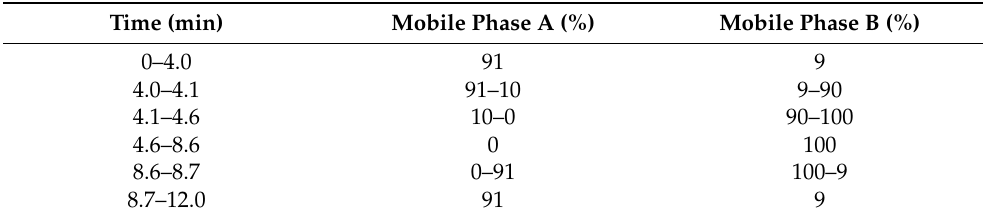
Table 6. Gradient used for the analysis of desfuroylceftiofuracetamide and desfuroylceftiofuracetamide-d3. With mobile phase A: 0.005% ( v / v ) formic acid in H 2 O and mobile phase B: acetonitrile. Time (min) Mobile Phase A (%) Mobile Phase B (%)